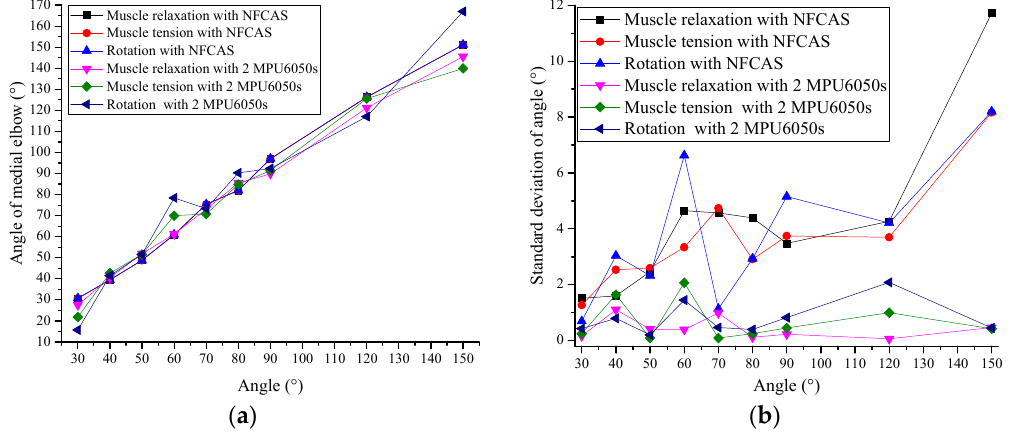
Figure 4. Experimental results of forearm rotation and muscle deformation. ( a ) Angle of medial elbow; ( b ) Standard deviation of angle.